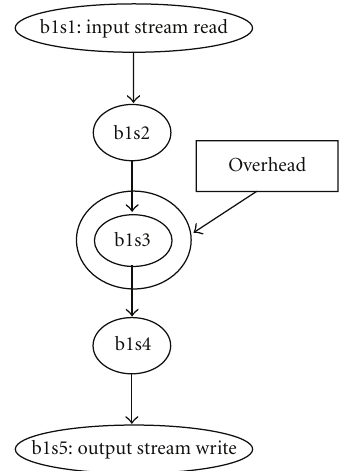
Figure 4: State machine with parallel assertion.